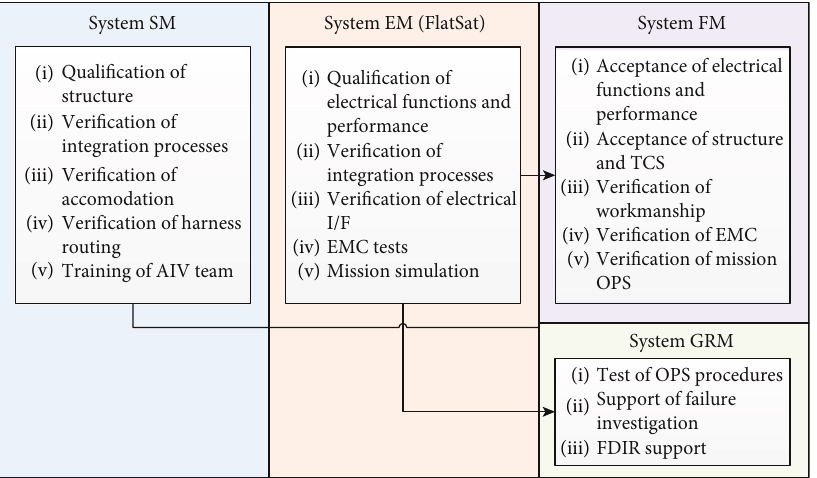
Figure 5: Model philosophy for